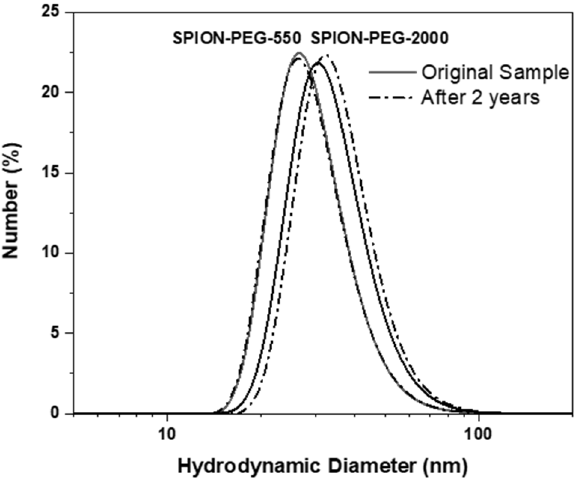
Figure 1. Particle size distribution in water determined by dynamic light scattering (DLS) measure- ments after being synthesized and after two years of storage.